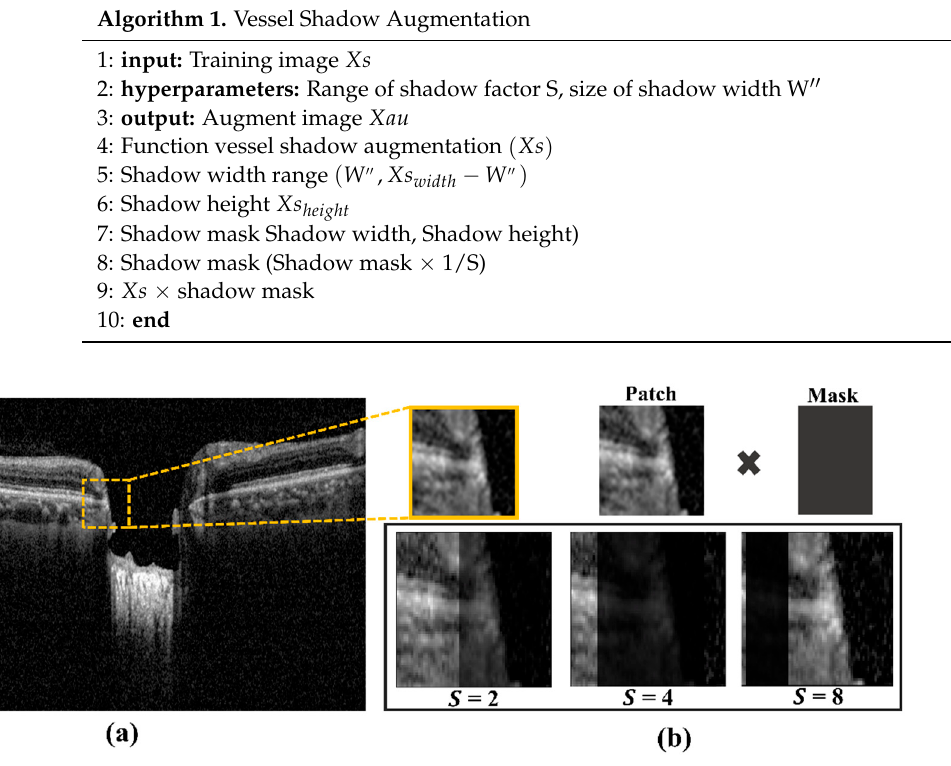
Figure 4. ( a ) The vascular shadow generation technique, ( b ) results according to shadow factor value ( S = 2, 4, 8). Scale bar: 400 µm.